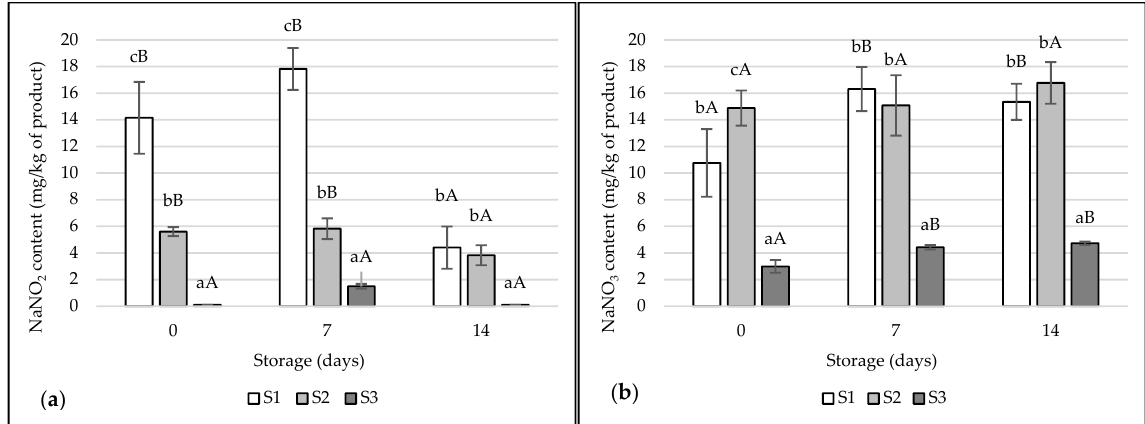
Figure 1. Content of NaNO 2 ( a ) and NaNO 3 ( b ) in the tested samples of pork hams. The values are expressed as means ± SD. Values marked with lowercase letters (a–c) differ significantly between treatments. Values marked with capital letters (A,B) differ significantly between storage times.